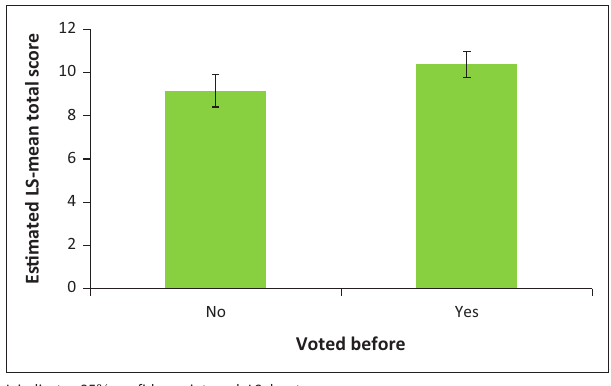
I, indicates 95 % confidence interval; LS, least squares. FIGURE 3: Post-hoc testing of the estimated mean total Cognitive Assessment Tool for Voting scores for those who had voted before compared with those who had